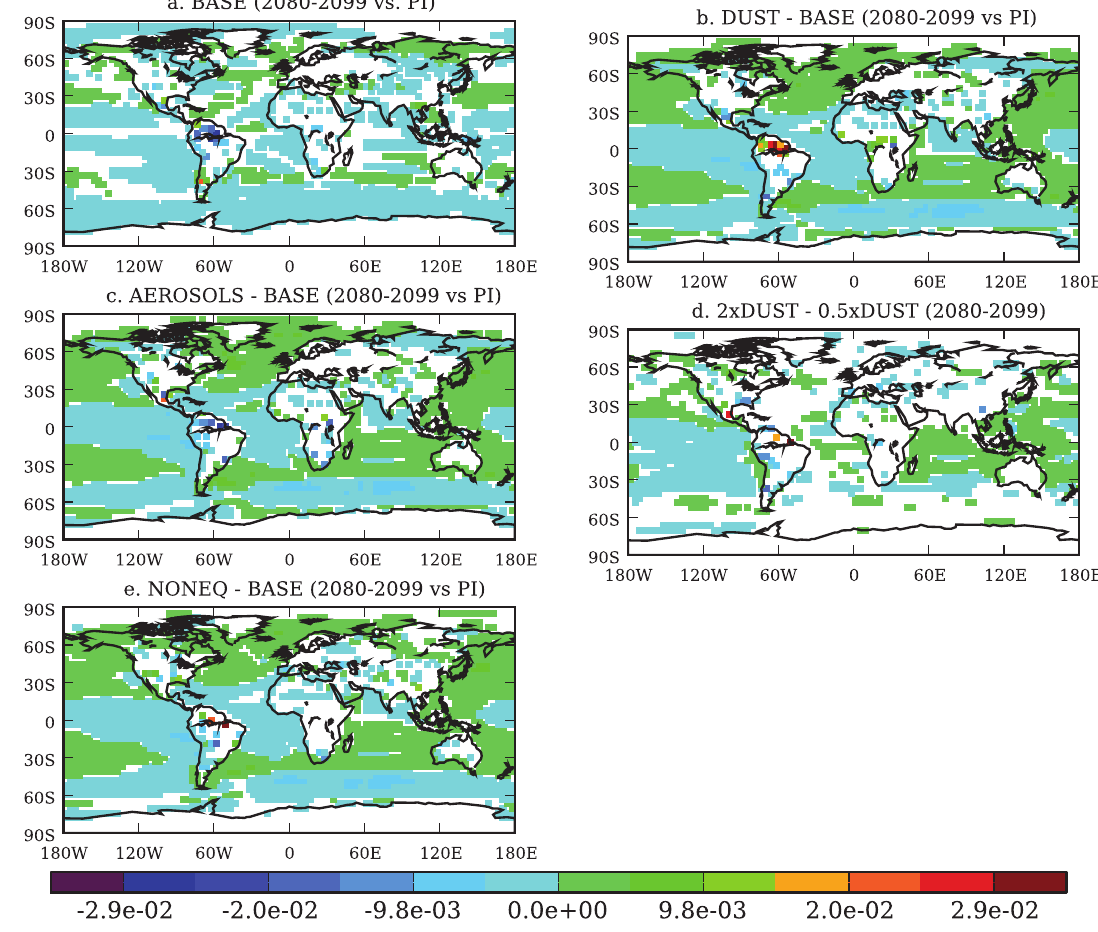
Fig. A5. Surface CO 2 flux (mg CO 2 m − 2 s − 1 ) differences for 2080–2099 versus the first twenty years of the same simulation for each case: (a) mean change for 3 ensemble base case members, (b) differences from base case differences for interactive dust (DUST), (c) differences from base case for interactive aerosols (AEROSOL), (d) difference between 2 × DUST and 0.5DUST cases, (e) differences from base case for case of NONEQ, and (f) differences from base for case of TRAJ. Only changes significant at the 95% level are shown in color. Note that panels (b) , (c) , (e) and (f) show differences from the 3 BASE case differences from the beginning of the simulation (for example: (DUST2080-2099 minus DUST-1870-1889) minus (BASE2080-2099 minus BASE-1870-1889)). This figure is the same as Fig. 10 in the main text, but without removing any drift in the control simulation.